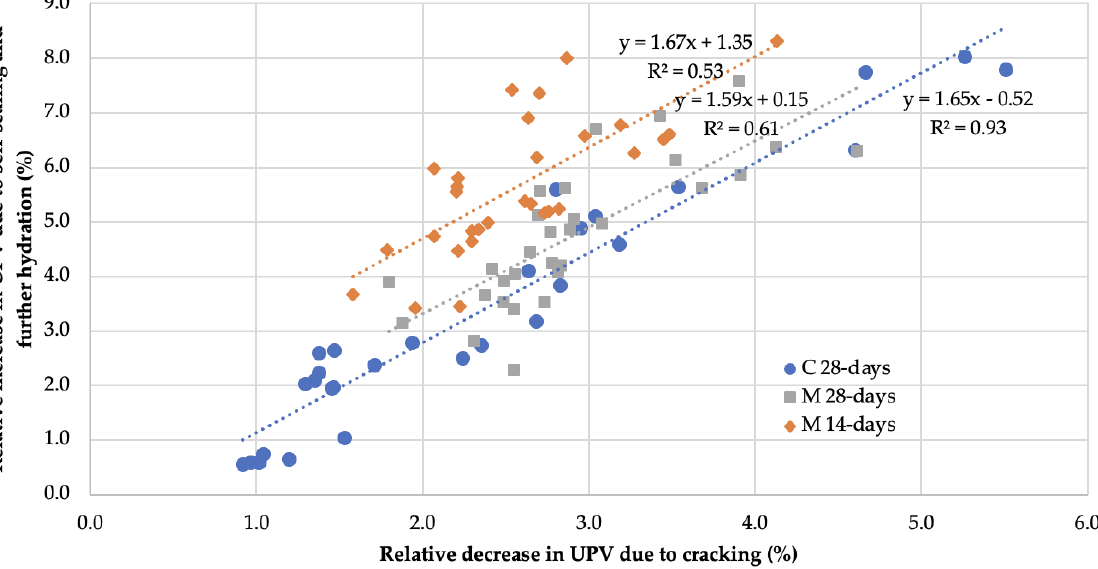
Figure 9. Graph of relative velocity changes of UPV due to self-sealing and further hydration of binders after 122 days of curing versus relative UPV changes due to mechanical induction of defects in concrete and mortar samples.